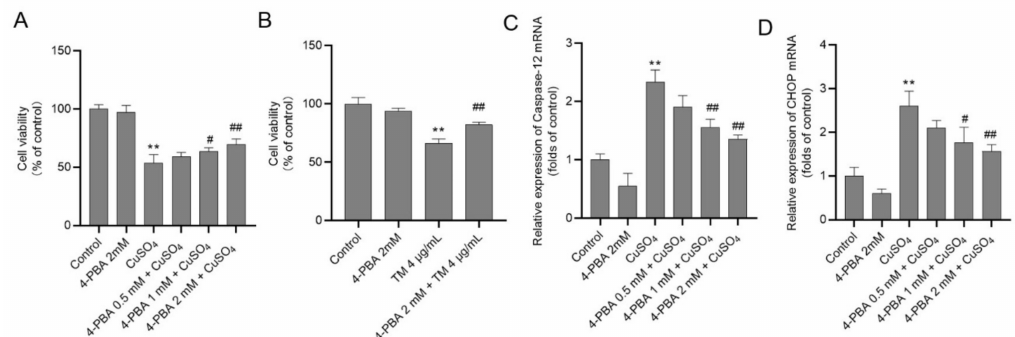
Figure 8. 4-phenylbutyric acid (4-PBA) inhibits CuSO 4 exposure-induced cytotoxicity and endoplasmic reticulum (ER) stress in HEK293 cells. ( A ) 4-PBA pre-treatment at the doses of 0.5, 1, and 2